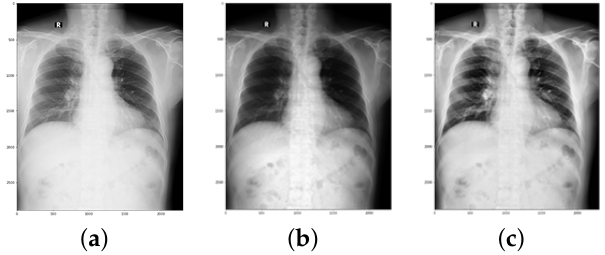
Figure 8. Stain-normalization outcomes: ( a ) original image, ( b ) Reinhard approach, and ( c ) Macenko approach.